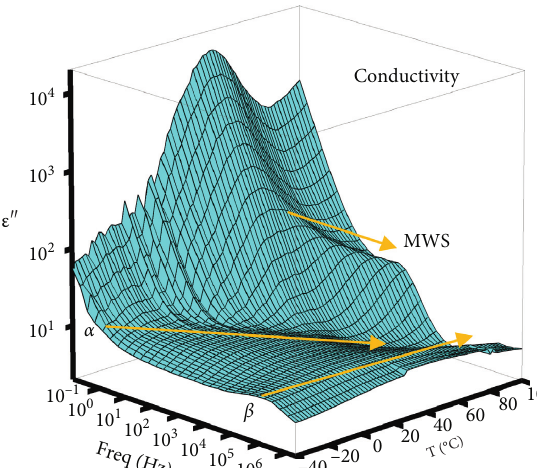
Figure 11: 3D plot of the imaginary permittivity for